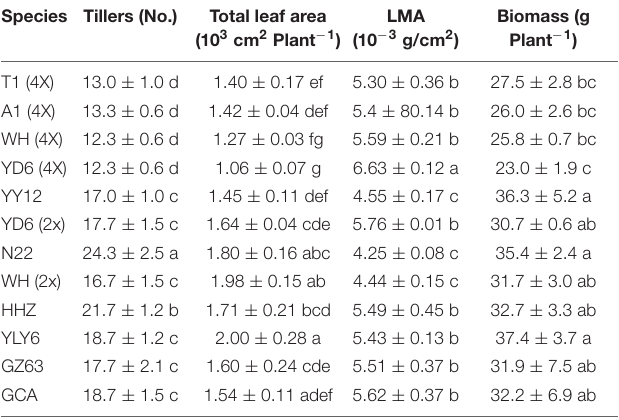
TABLE 2 | Differences of plant growth across twelve rice genotypes. Species Tillers (No.)